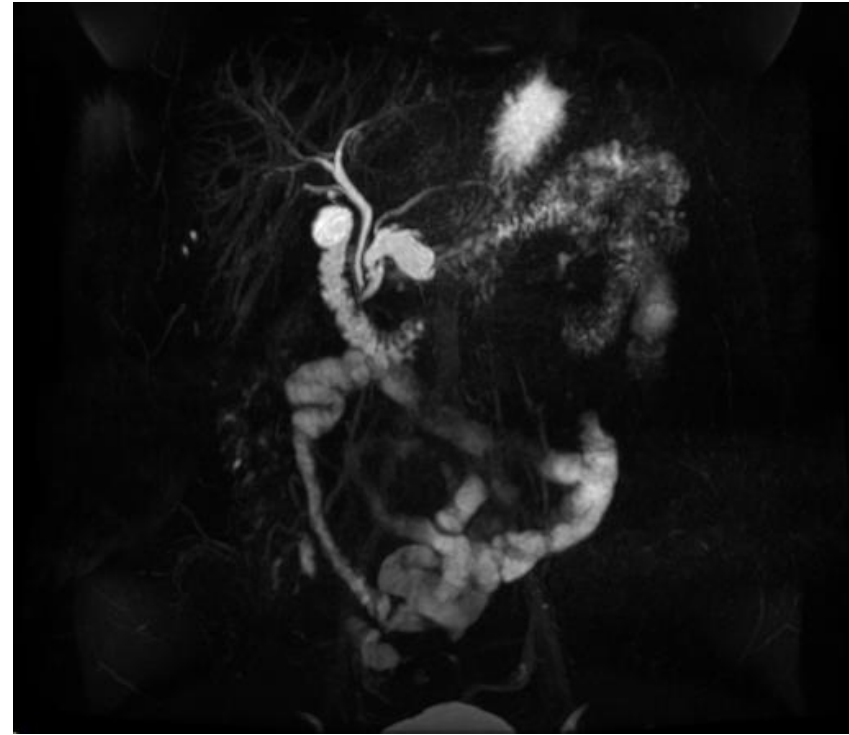
Figure 4. MRI image of mixed IPMN.